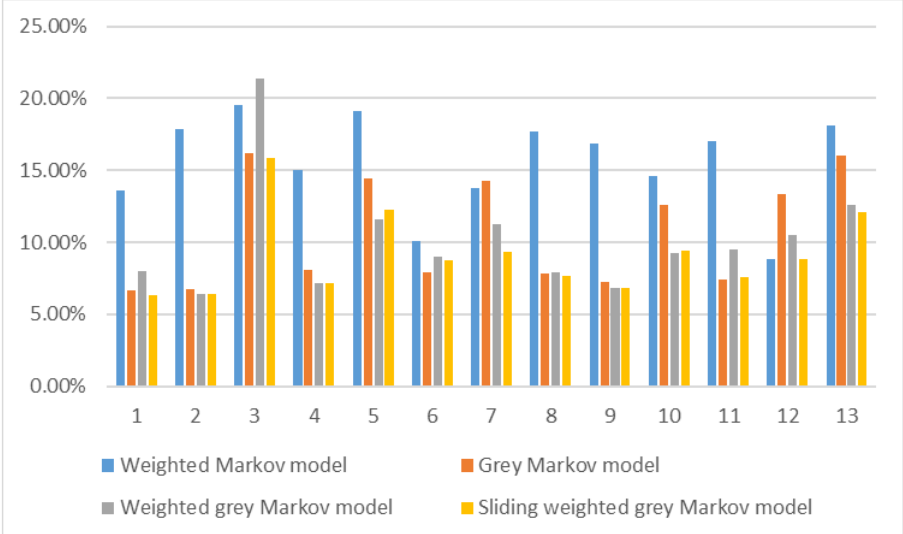
Figure 2. Average relative error of four models.